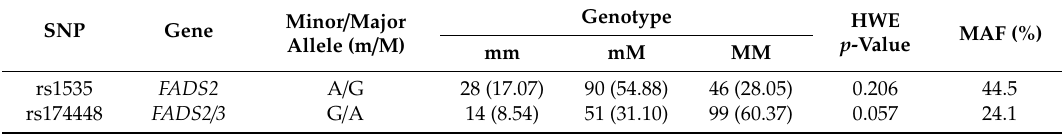
Table 2. Distributions of the two single nucleotide polymorphisms (SNPs) in study participants 1,2,3 .